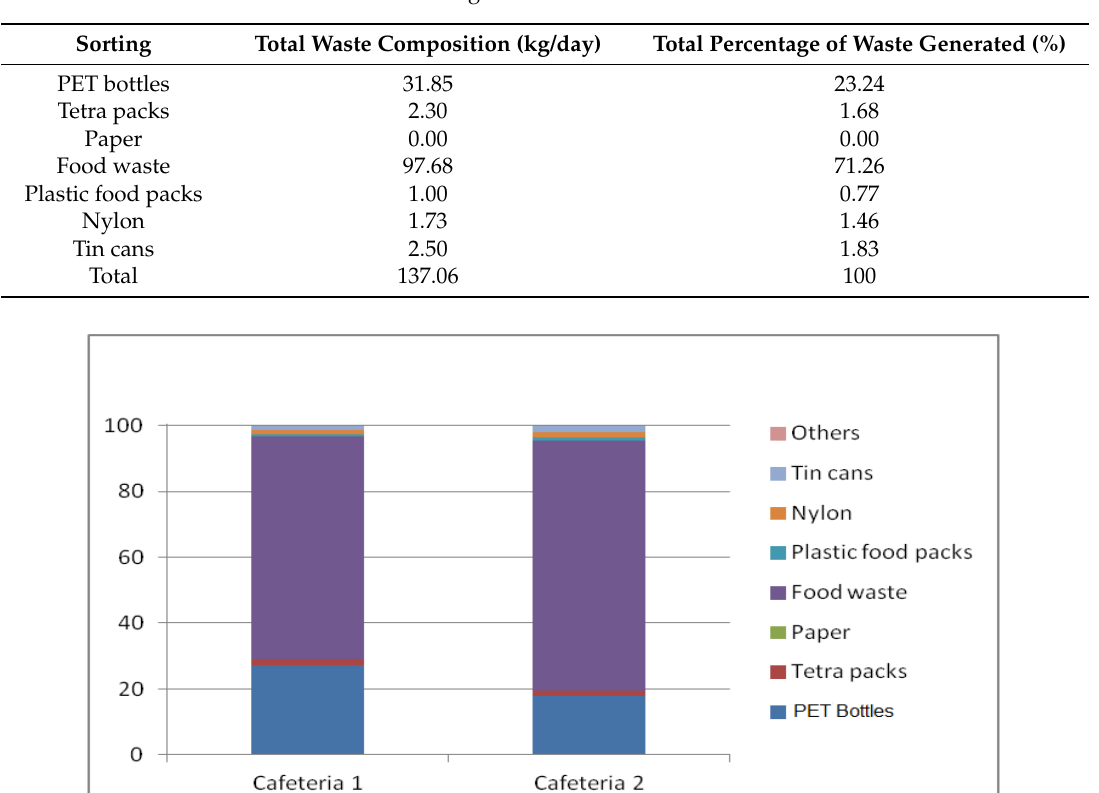
Figure 3. Percentages of waste obtained from the two cafeterias.